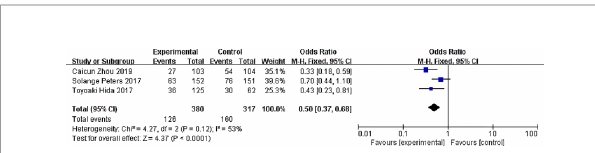
FIGURE 10 | Meta-analysis of grades 3 to 5 adverse events between the alectinib group and crizotinib